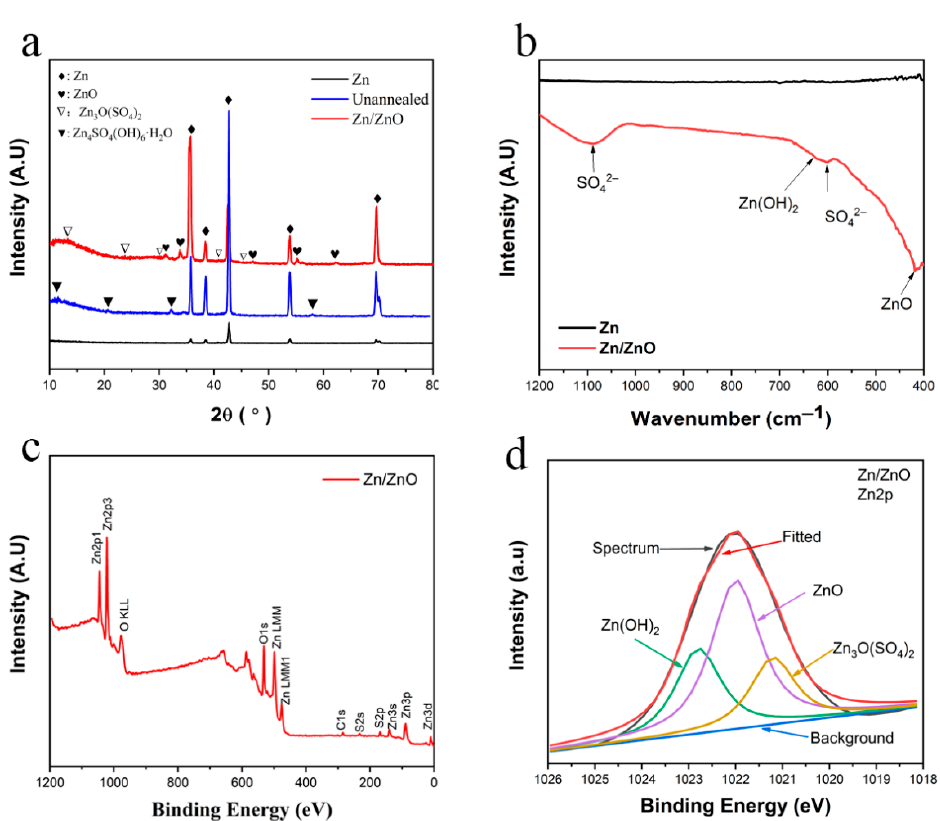
Figure 4. Characterization of as-prepared samples after annealing at 400 °C for 2 h: ( a ) XRD patterns of pure Zn and Zn/ZnO, ( b ) FTIR spectra of Zn and Zn/ZnO, ( c ) XPS spectra of Zn/ZnO, and ( d ) high-resolution XPS spectra of Zn/ZnO.